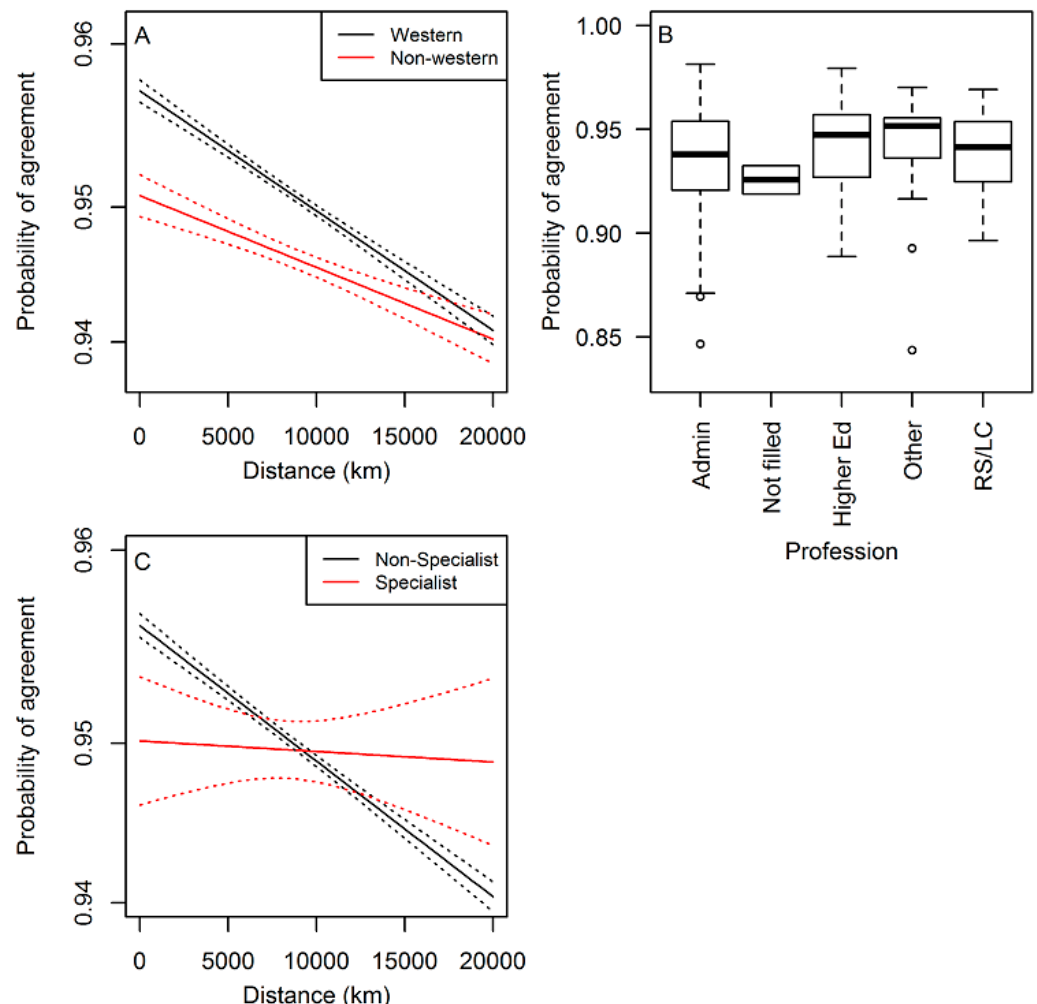
Figure 3. Predicted probability of agreement with the majority of ratings for an image in the Cropland Capture game. ( A ) As a function of the image location’s great circle distance from home and a volunteer’s home region (‘western’ includes North America, Europe, and Oceania; ‘non-western’ is Asia, Africa, and Latin America); ( B ) As a function of self-reported profession. RS/LC stands for ‘Remote sensing/land cover’. Differences among groups are non-significant (see main text); ( C ) As a function of image distance from home and professional background. The ‘specialist’ professional background applies to users who reported their profession as ‘remote sensing or land cover’, while the ‘non-specialist category applies to everyone else. The dotted lines show ± 2 standard error confidence intervals. The y-axes in panels A and C are on a logit scale due to the binomial probability model used for the response variable. Note the small range of values on these y-axes—this indicates low explanatory power of the models, in spite of their statistical significance (see main text).